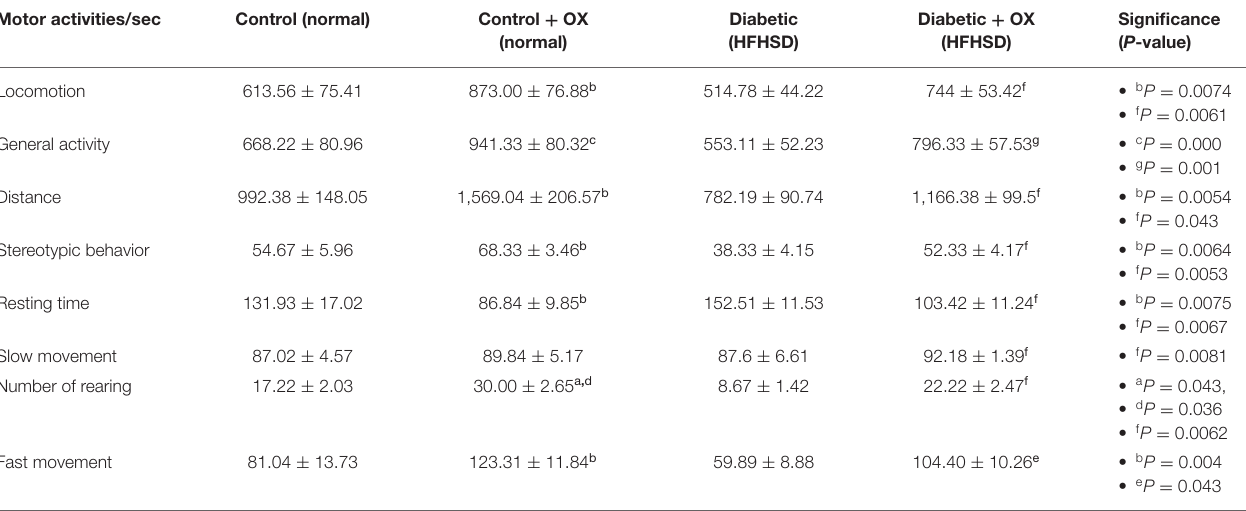
TABLE 4 | Motor activity/sec (mean ± SEM) in different groups of Wistar rats.